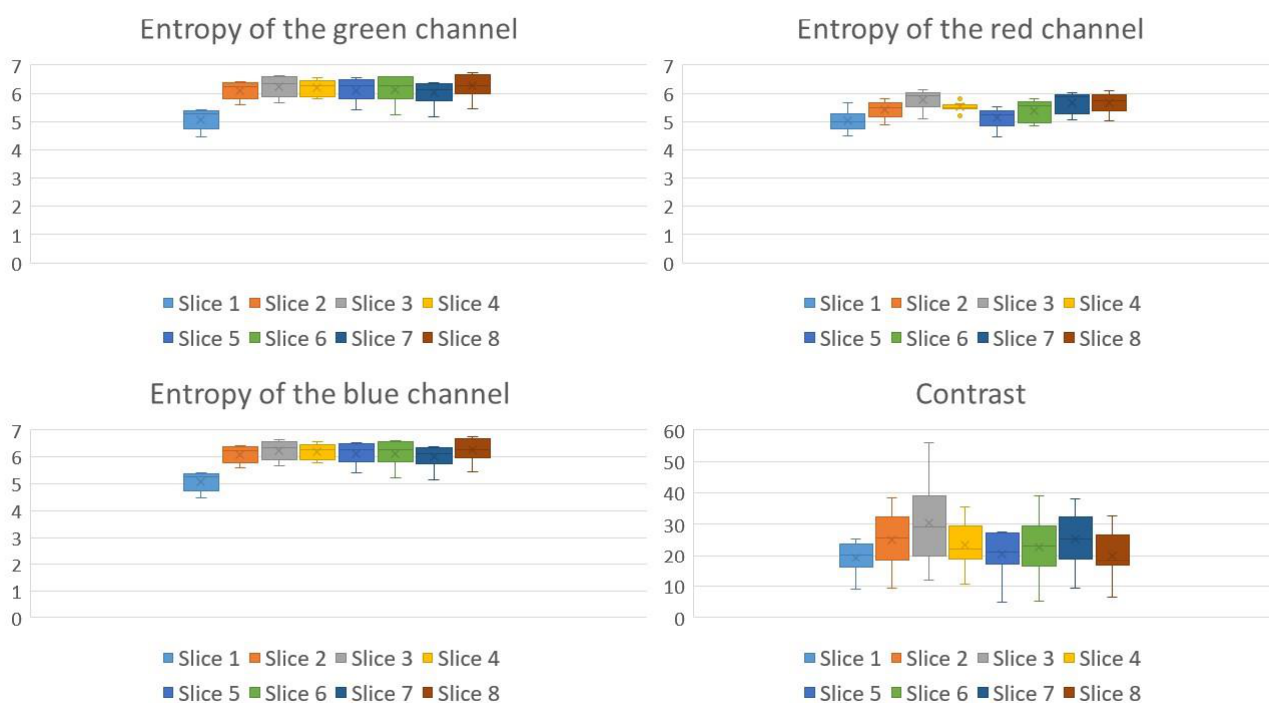
Figure 10. Drying curves for additional visual features.